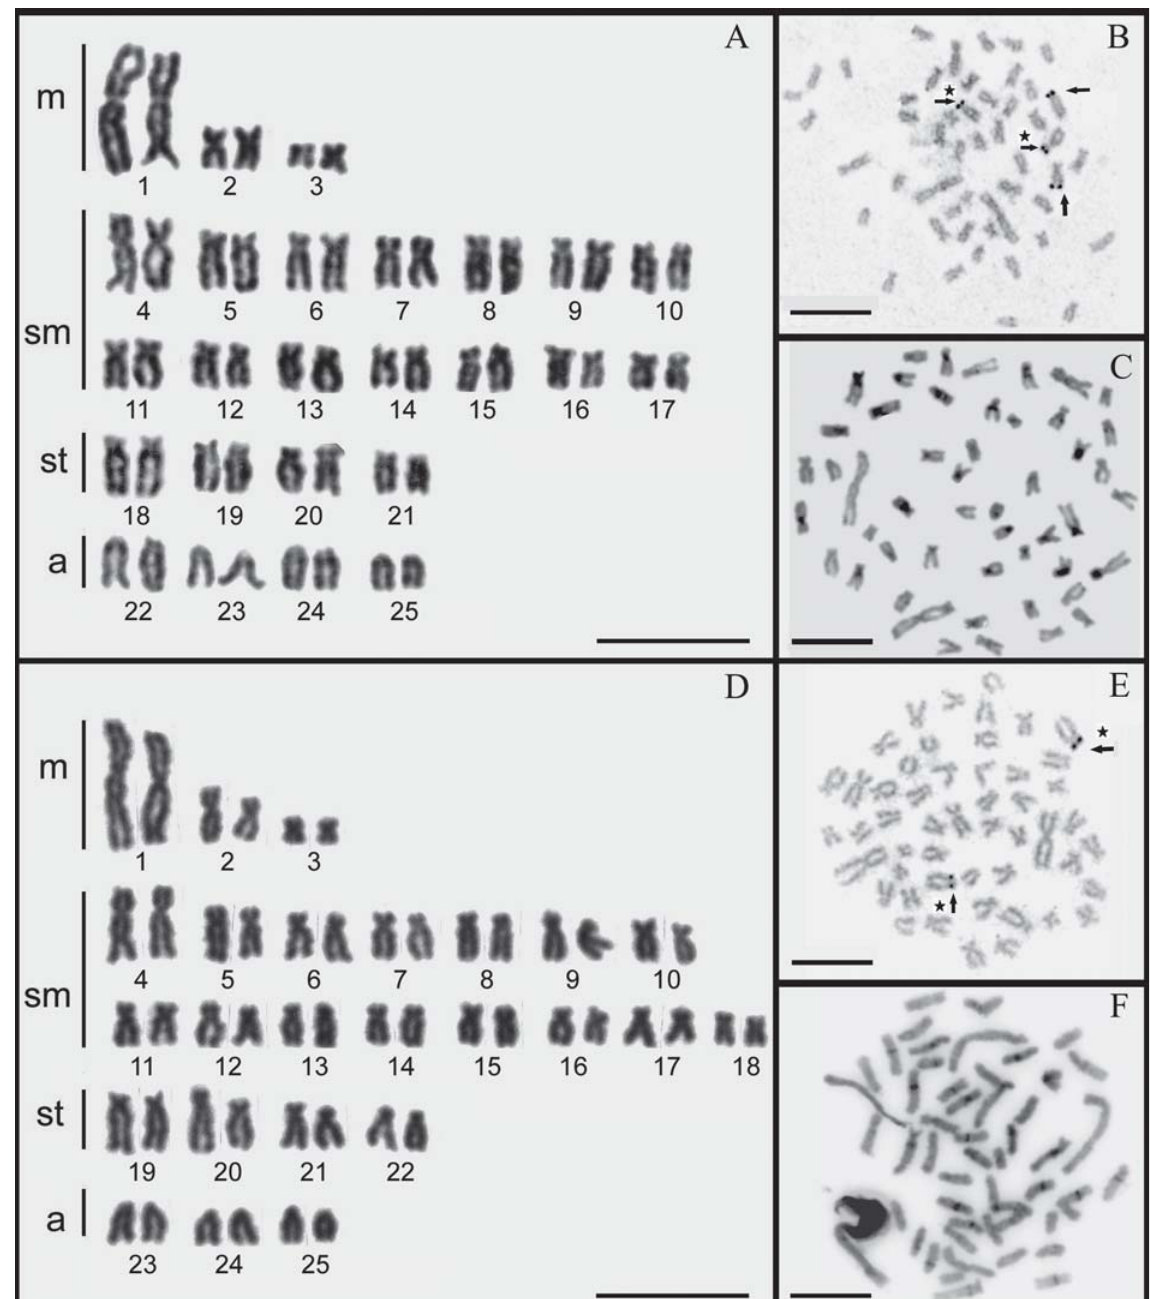
Fig. 2. Giemsa stained karyotypes (A and D); metaphases highlighting Ag-NORs (B; E) and C-banding (C; F) of Astyanax altiparanae from the upper rio Tibagi and upper rio Iguaçu, respectively. The black stars indicate the chromosomes more frequently bearing the Ag-NORs. Bar=5 µ m and 2.5 µ